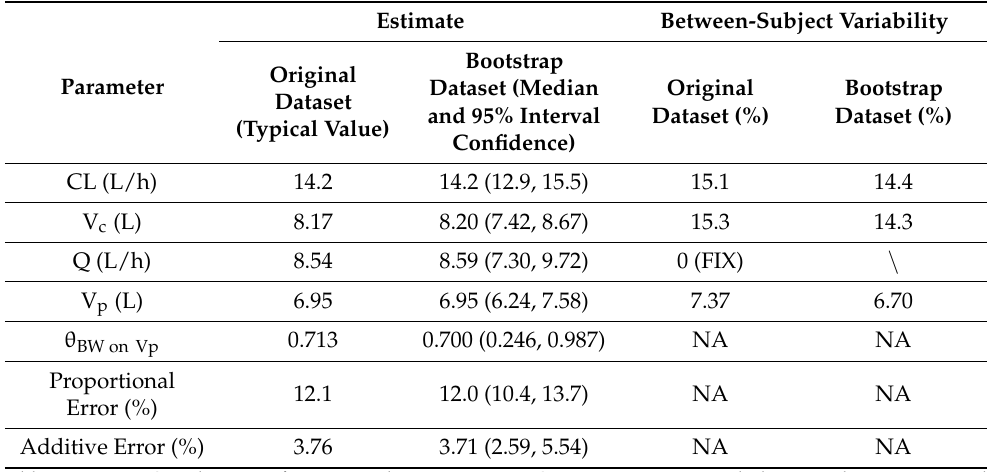
Table 4. Population pharmacokinetic parameters of